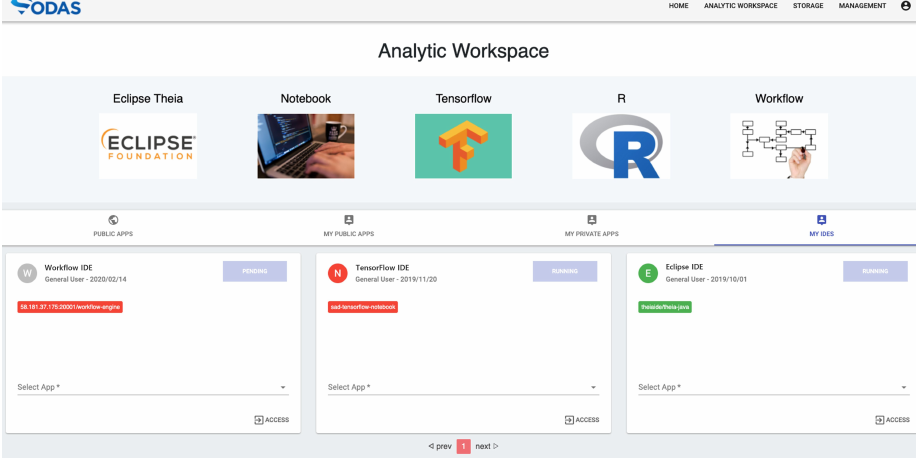
Figure 15. Example screen of ADE Provisioning main